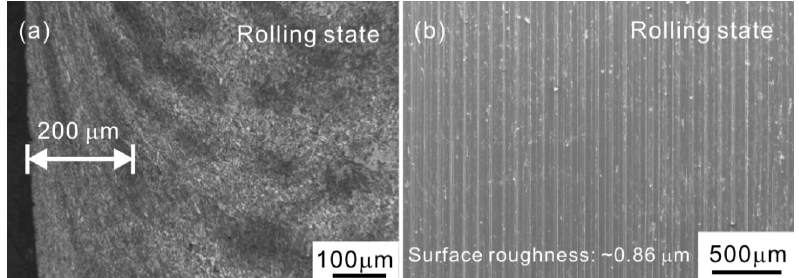
Figure 10. ( a ) Optical micrograph of the cross-section and ( b ) scanning electron microscope (SEM) observation of the surface morphology in the specimen with the rolling state.